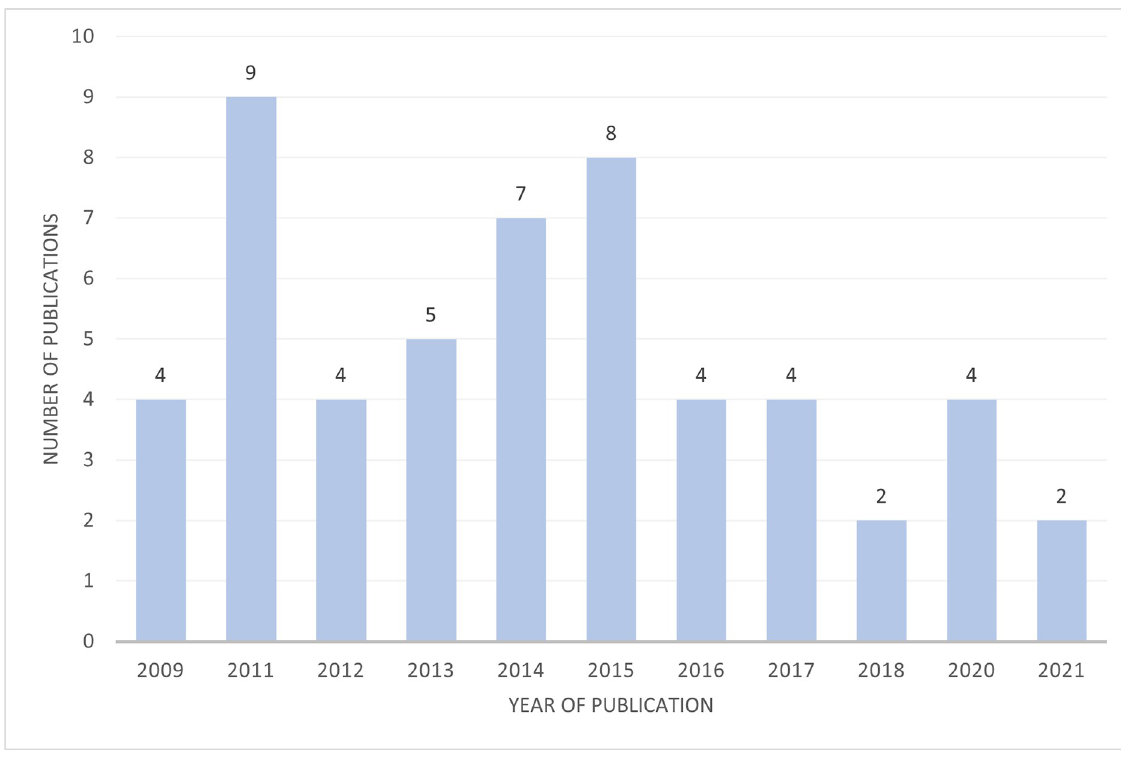
Fig 2. CCS/CCUS site specific